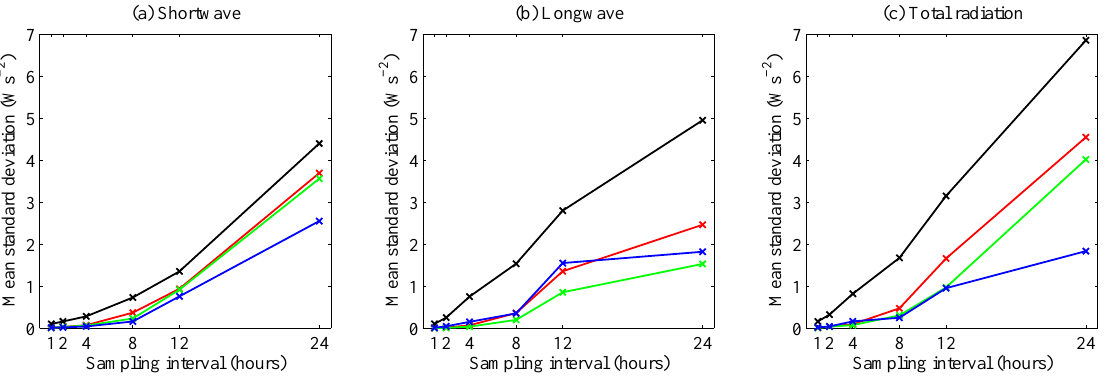
Figure 11. As for Figure 7, ( a ) shortwave; ( b ) longwave and ( c ) total radiation, but for the Arctic